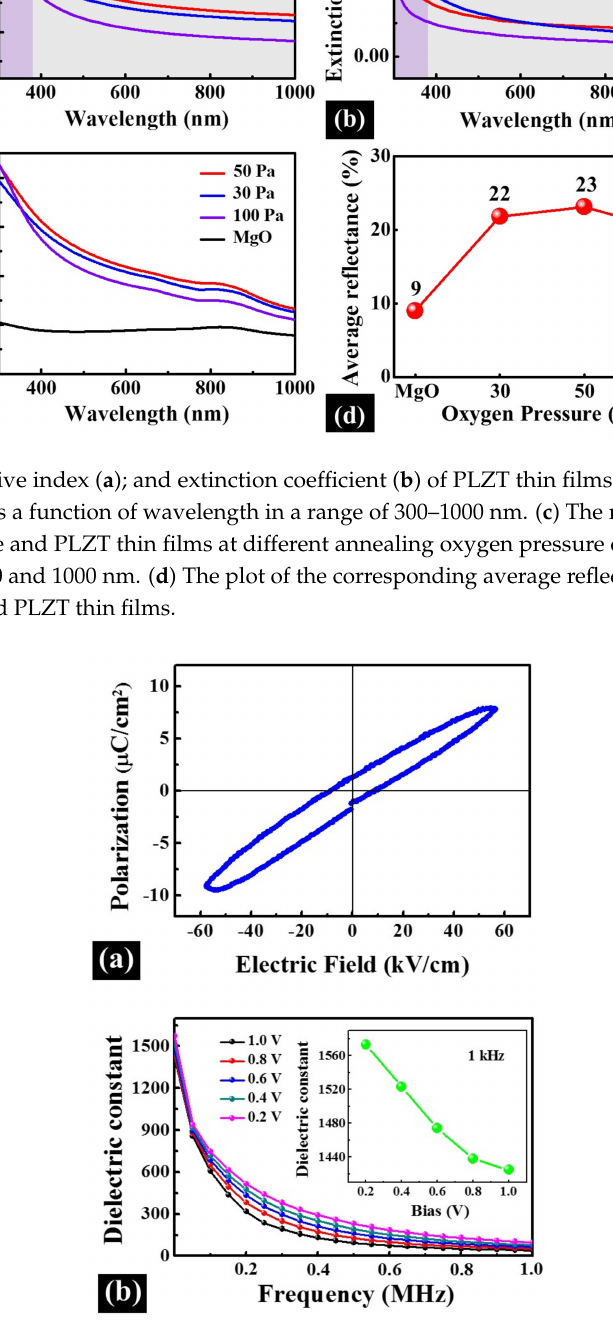
Figure 11. ( a ) The P-E loop; and ( b ) room-temperature frequency dependent dielectric constant of PLZT thin films fabricated at 750 ◦ C under the oxygen pressure of 50 Pa during annealing. The inset is the dielectric constant of PLZT thin films as a function of the bias voltage with the fixed frequency of 1